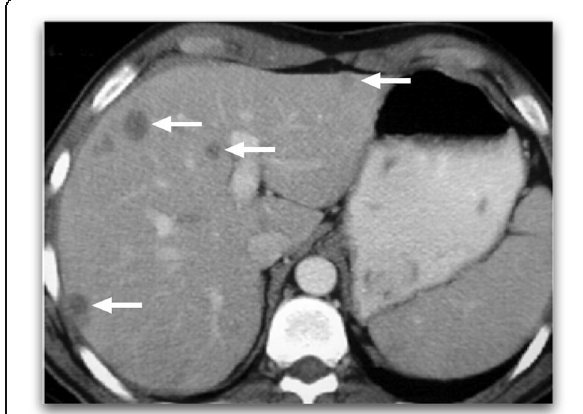
Fig. 17 A 55-year-old male with newly diagnosed HIV infection who presented with high fever and generalized abdominal pain. His CD4 + lymphocyte count was also significantly low at the time of his presentation. Axial plane postcontrast CT scan revealed several small hypoattenuating lesions scattered throughout the liver parenchyma (arrows). Based on his clinical context, the lesions were suggestive of pneumocystis jirovecii infection. Also note mild splenomegaly in this case which is an important suggestive finding for disseminated pneumocystis infection. Post treatment follow up confirmed almost complete regression of the imaging findings (not